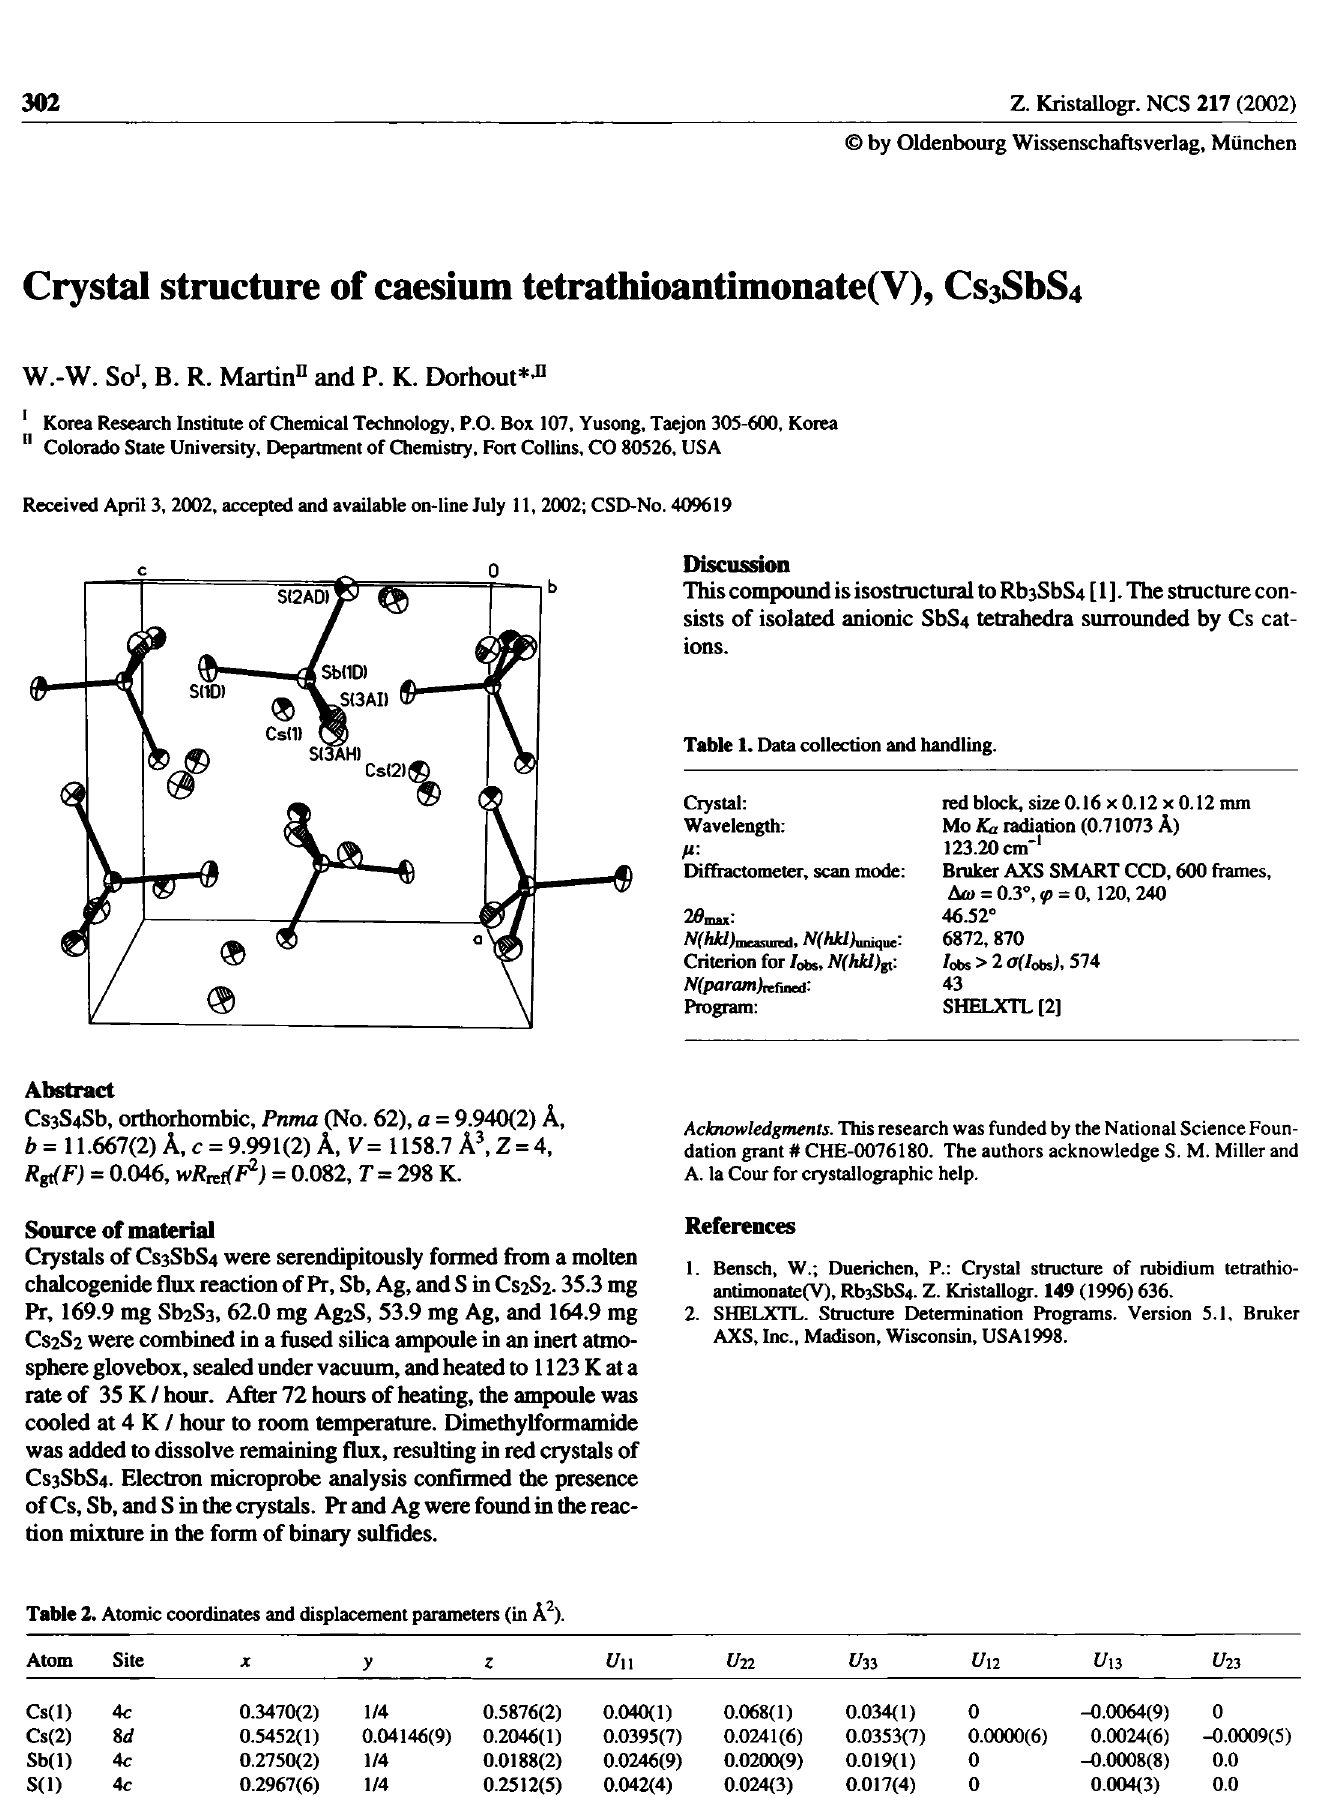
Table 2. Atomic coordinates and displacement parameters (in Ä 2